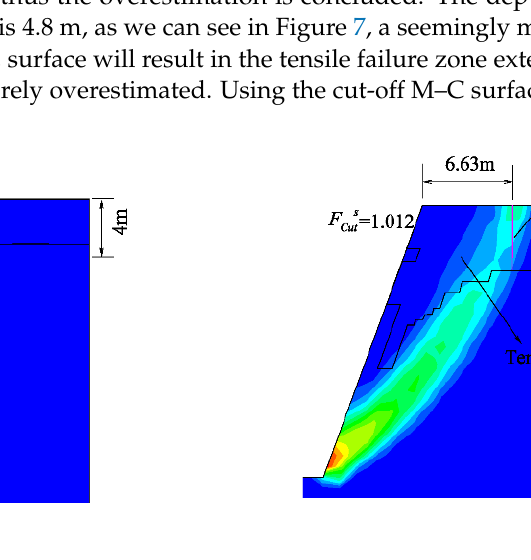
Table 1. Outcomes of different slope angles.